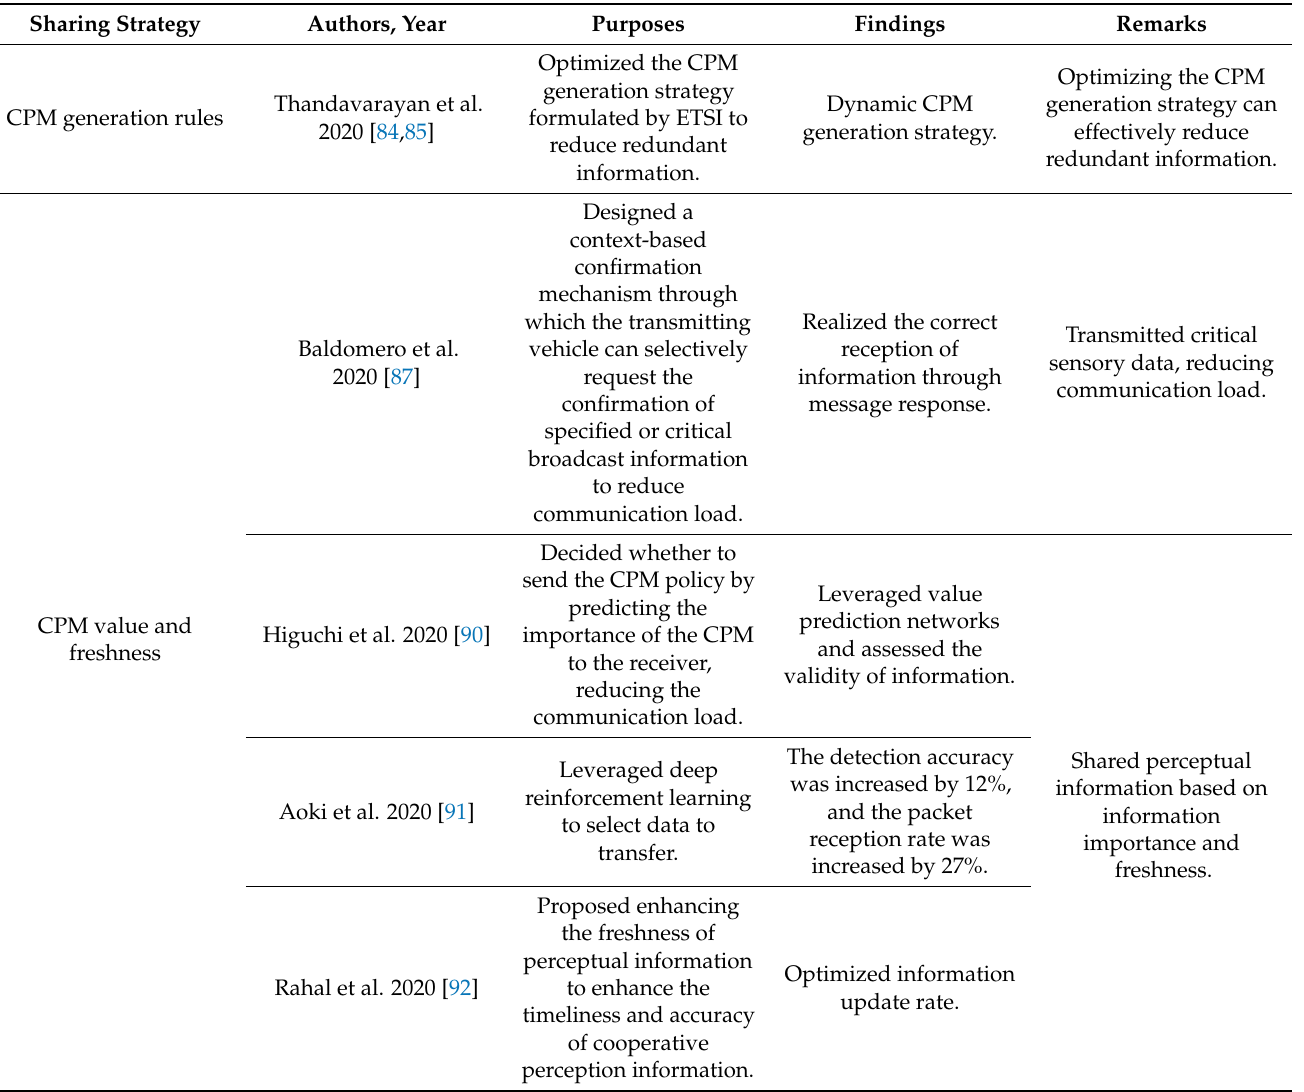
Table 7. Summary of the perceptual information-sharing strategies by type of shared